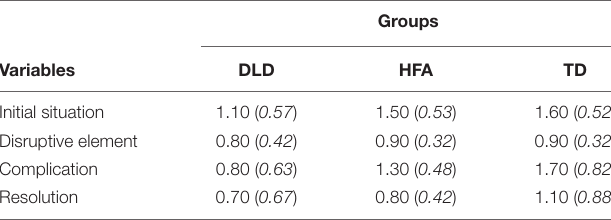
TABLE 3 | Mean (M) scores and standard deviations ( SD ) for each narrative step in the three groups.